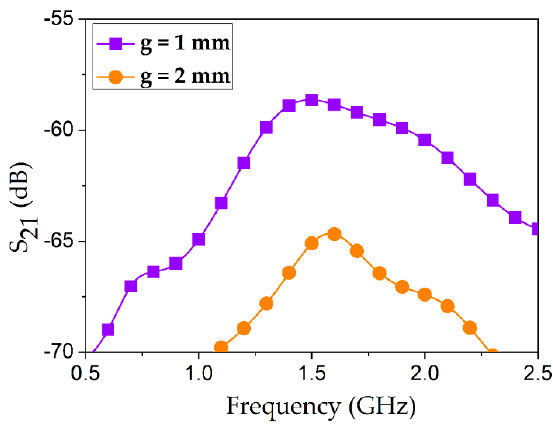
Figure 3. Insertion loss (magnitude of S 21 ) profile when a silver-coated 3D-printed SRR is excited using two capacitively coupled coaxial probes. Inset shows the complete assembly considered for this set of simulations. The coupling gap ( g ) was varied and the corresponding insertion loss values are shown. The curves are not sharp, and minimum IL is 58 dB, which is too lossy to consider for practical scenarios. This necessitates an additional assembly or modification in the design to reduce the losses and to obtain sharp resonances.